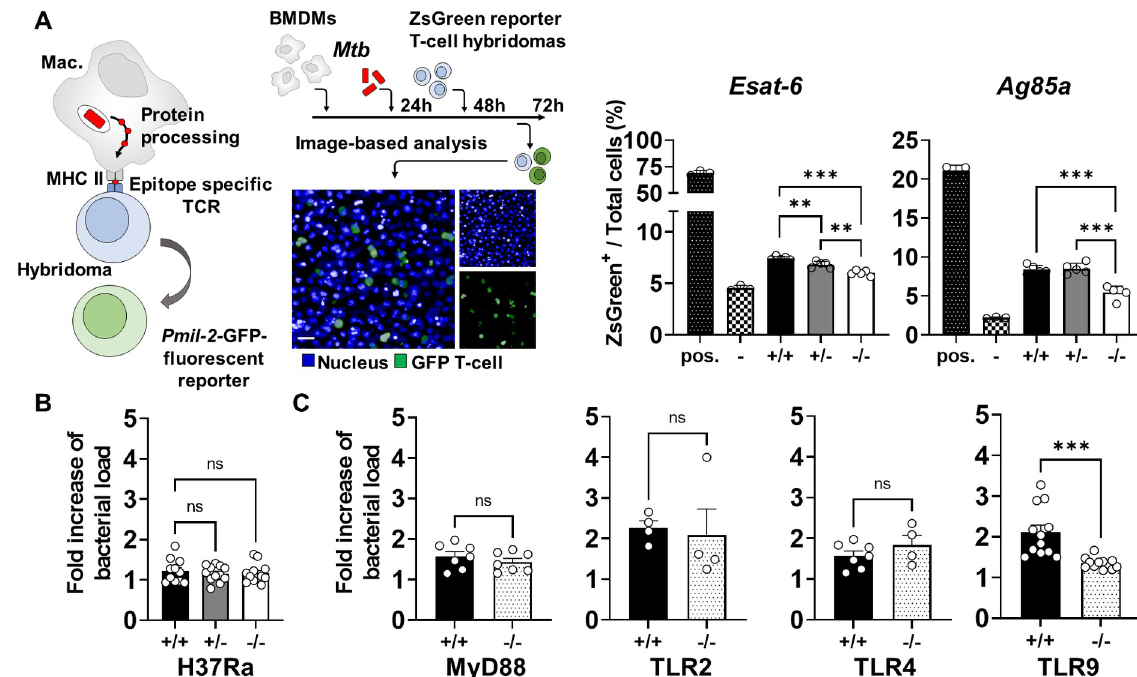
Fig 5. Tirap implication in Mtb effectors secretion. ( A ) BMDMs were seeded into 96-well plates and loaded with homologous (pos) or control (-) peptides or infected with Mtb H37Rv-DsRed. 24 hours post incubation, cells were washed and co-cultured with transduced anti- Ag85 or anti-Esat6 reporter T-cell hybridomas. These were then analyzed by automated confocal microscopy. Shown are representative images of DAPI labelled T-cells (blue) and Antigen specific T-cells (green). Histograms showing mean ± SEM of percentage of ESAT-6 or Ag85 specific T-cells obtained from 5 analysed wells. ( B ) BMDMs from WT, Tirap +/- and Tirap -/- mice were infected with an attenuated strain of Mtb (H37Ra-GFP) (MOI of 2) and analyzed by automated confocal microscopy. The histogram shows the replication fold increase from 3 hpi to 4 dpi. Shown are mean ± SEM obtained from at least 12 analyzed wells per condition. ( C ) WT (+/+), knocked-out (-/-) for Myd88, TLR2, TLR4 and TLR9 BMDMs were infected with H37Rv-GFP (MOI of 2) and analyzed by automated confocal microscopy. The histogram shows the replication fold increase from 3 hpi to 4 dpi. Shown are mean ± SEM obtained from at least 4 analyzed wells per condition of one representative out of two independent experiments. ��� P value < 0.001 as determined by one-way ANOVA